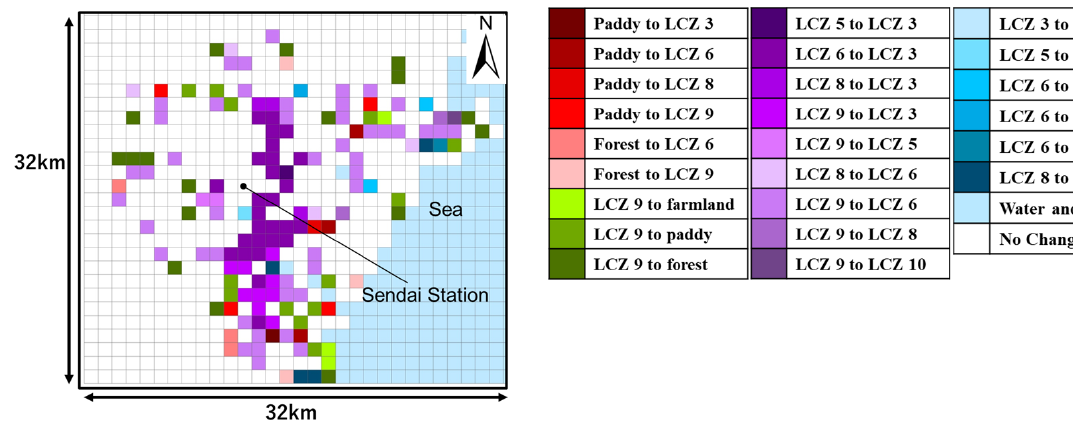
Figure 4. Land use changes between 2002 and 2022 in Sendai.